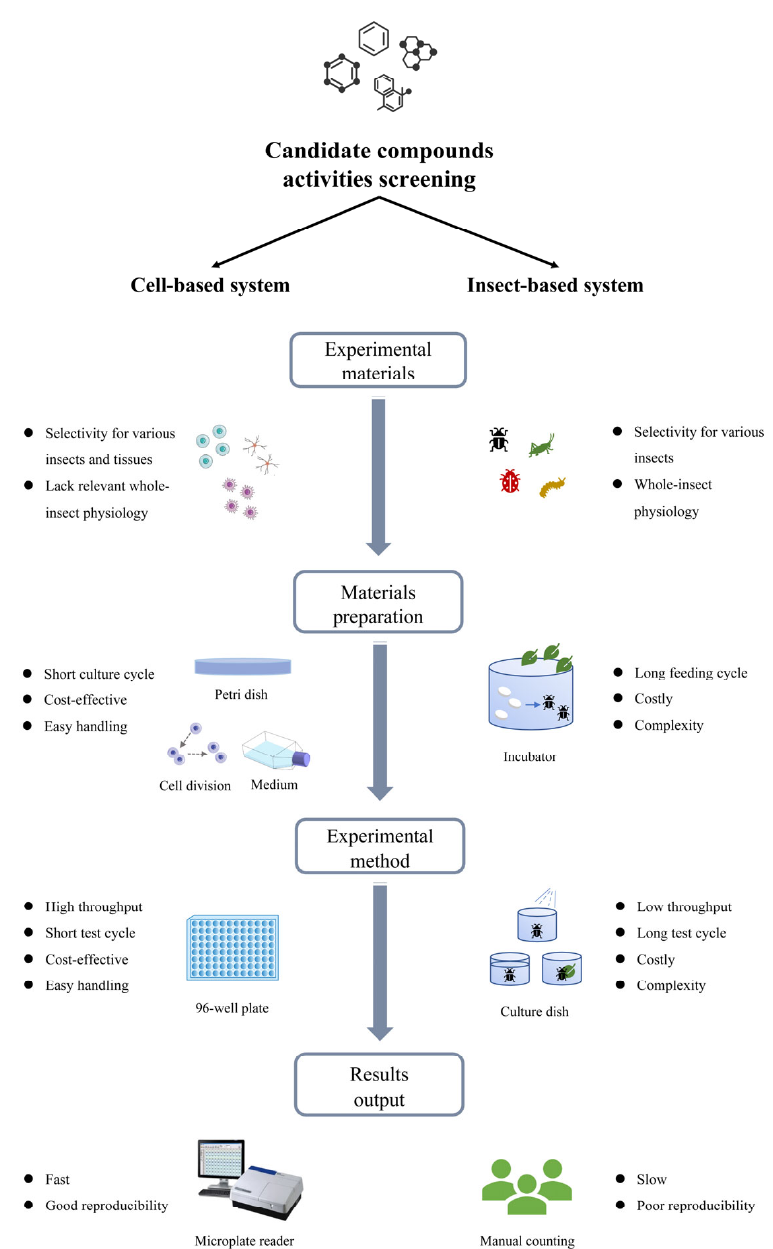
Figure 2. The flow chart of insecticide candidate activity screening based on cells and insects, re ‐ spectively.